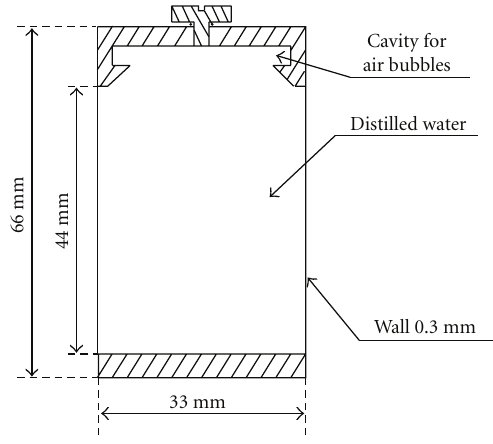
Figure 5: Dimensions of the micro-CT water phantom.